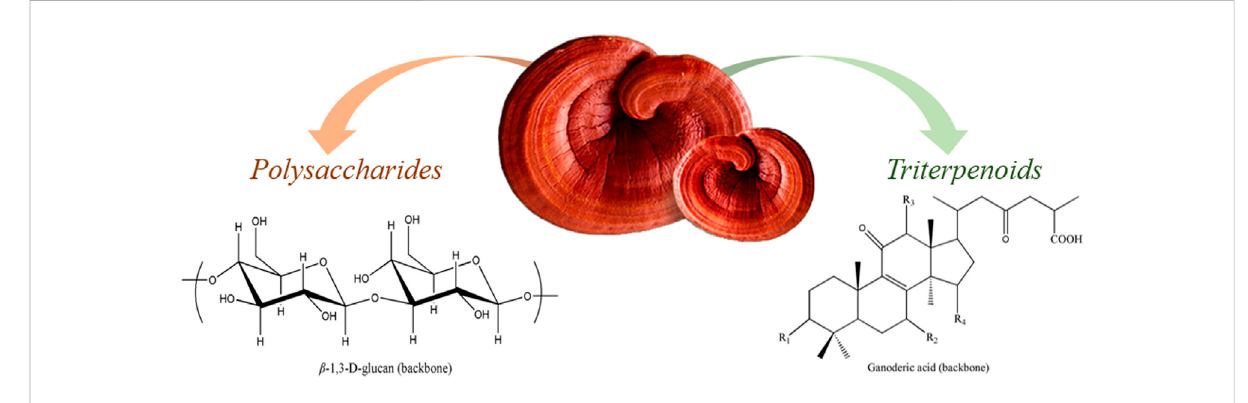
FIGURE 2 G. lucidum β -1,3-glucan and ganoderic